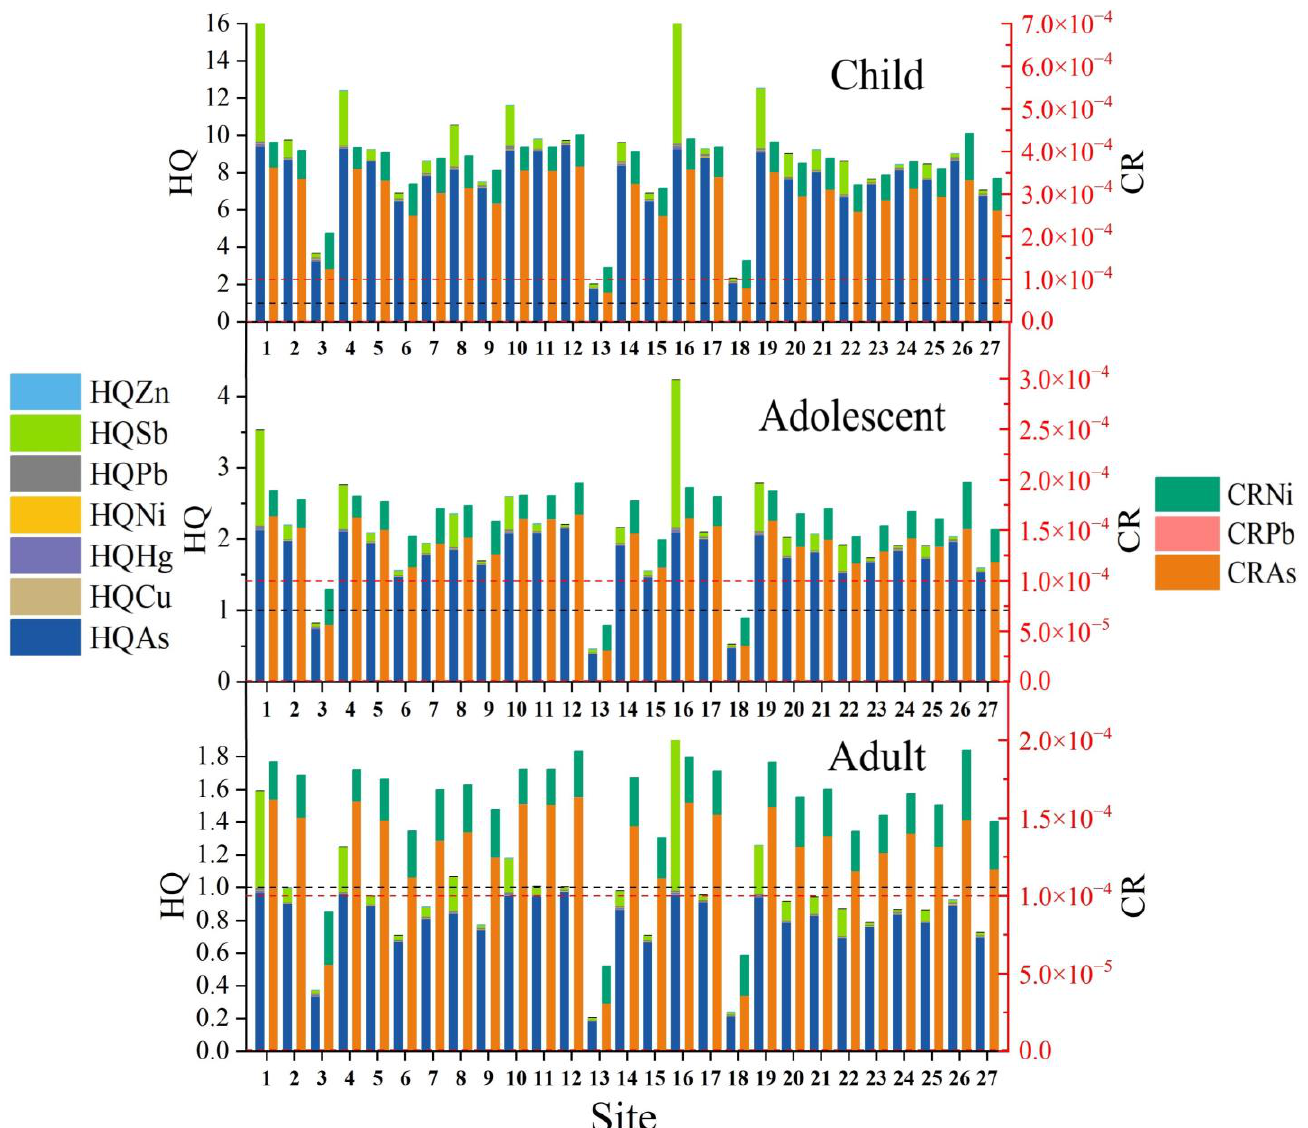
Figure 7. Non-carcinogenic and carcinogenic risks of different PTEs for three populations. The black reference line in Figure 7 is the reference line for HQ = 1 and the red reference line is the reference line for CCR = 10 −4 .